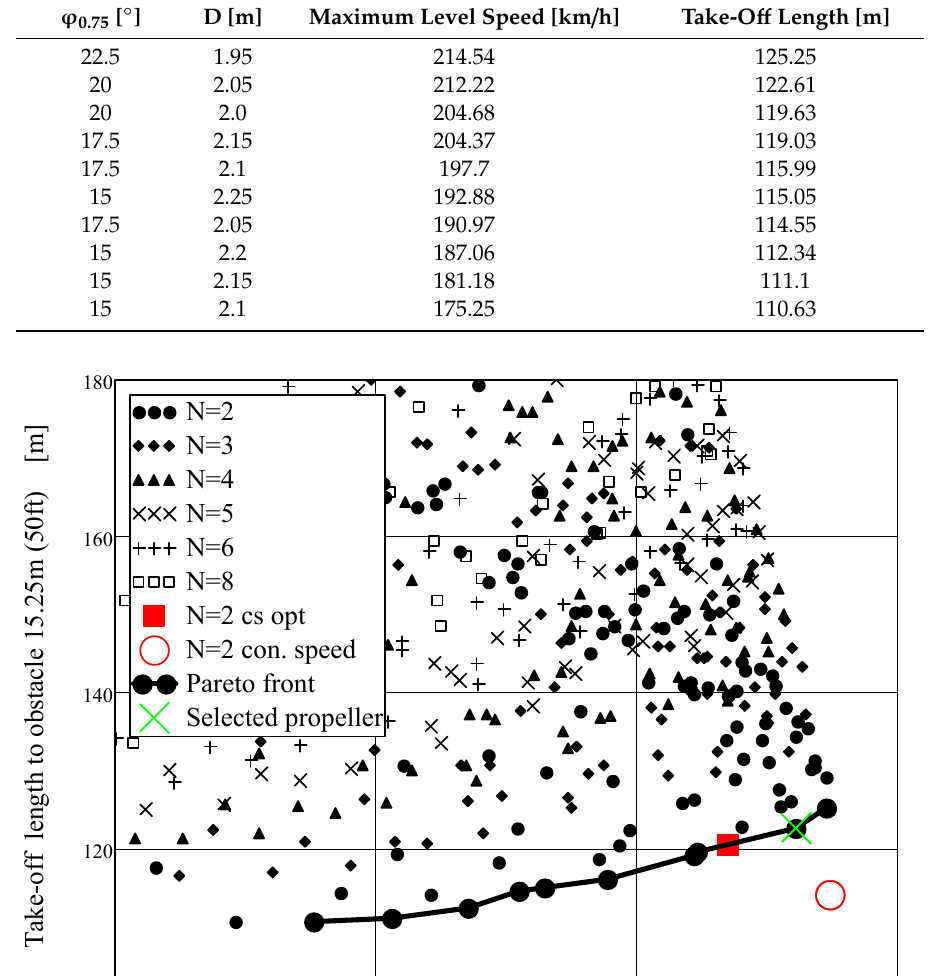
Table 1. Points on the Pareto front for maximum horizontal speed (continuous engine regime) and take-o ff distance (see Figure 6).